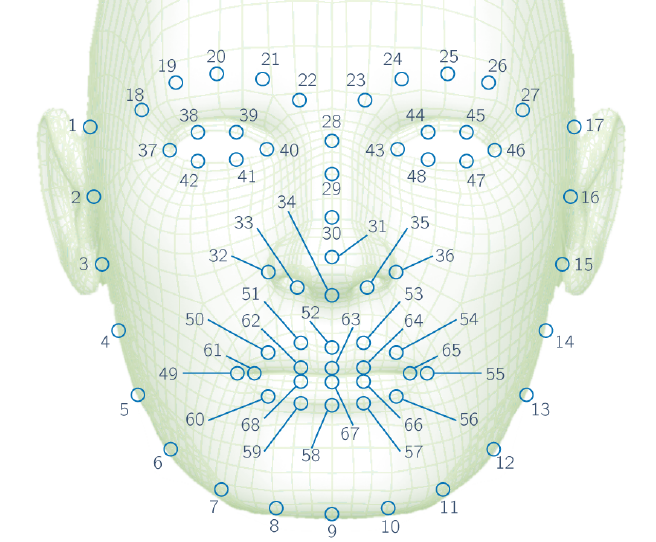
Figure 7. Numbered facial